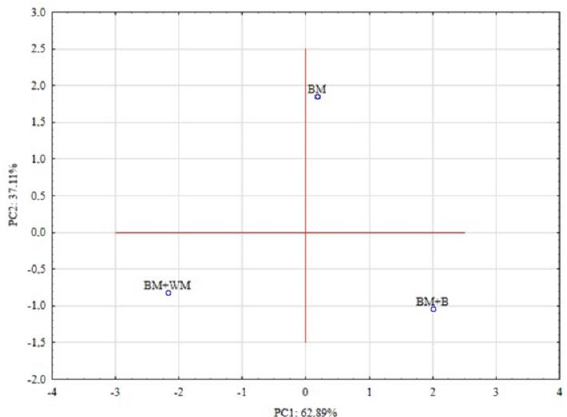
Figure 5. PCA plot of analysed observations.